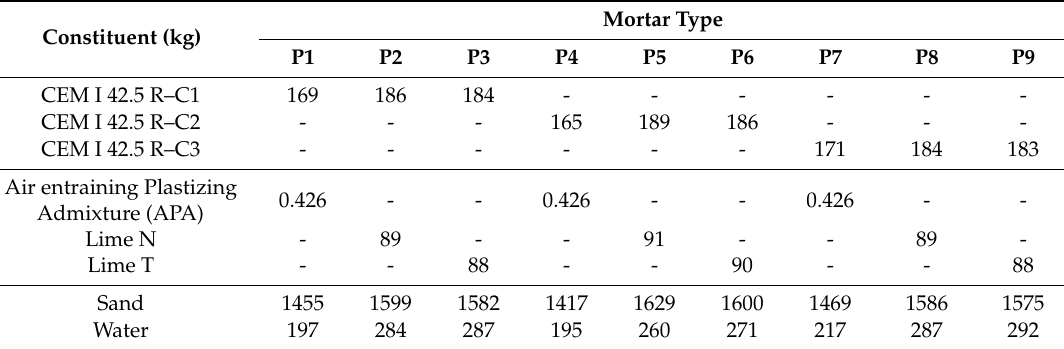
Table 3. The initial composition of plasters (kg / m 3 ).